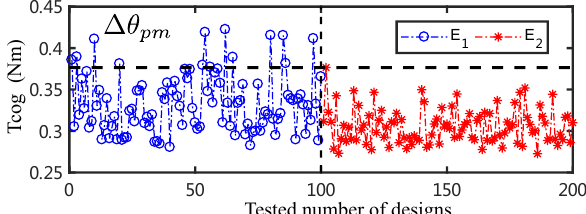
Figure 13. The comparison of cogging torque performance for different assembling approach consid- ering PM positioning